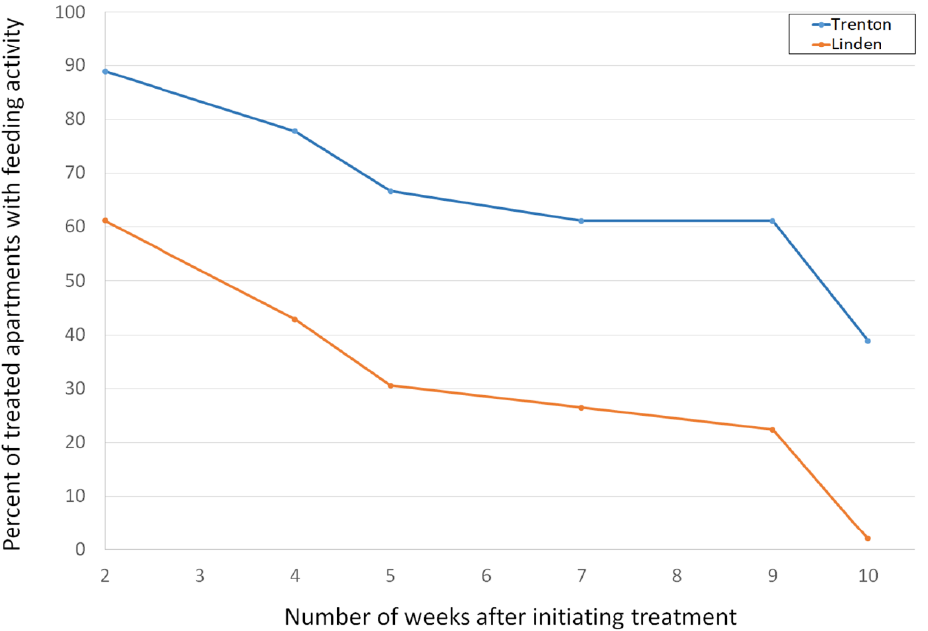
Figure 3. The dynamics of house mouse activity based on feeding activities on toxic baits in two high-rise apartment buildings after the implementation of a house mouse management program. The data are based on a total of 19 and 49 infested apartments at Trenton and Linden from January–April and February–June 2019, respectively.